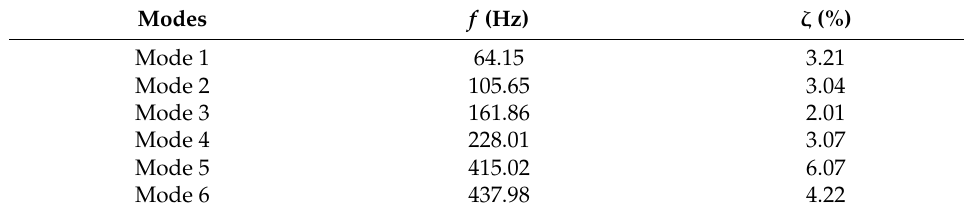
Figure 5. Steady state of EMA of gantry machine tool. Table 2. Dynamics of the spindle of the percussion experimental machine